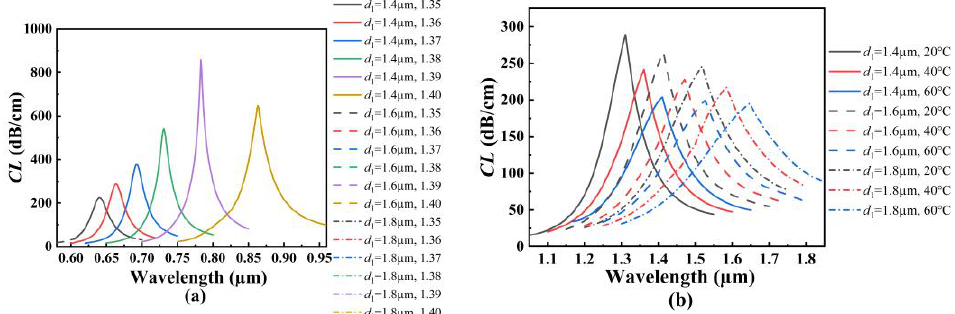
Figure 4. ( a ) The CL spectra of the core mode A when d 1 is set as 1.4, 1.6, and 1.8 μm, and when the analyte RI increases from 1.35 to 1.40, respectively. ( b ) The CL spectra of the core mode B when d 1 is set as 1.4, 1.6, and 1.8 μm, and when the temperature is chosen as 20, 4 0, and 60 °C, respectively.